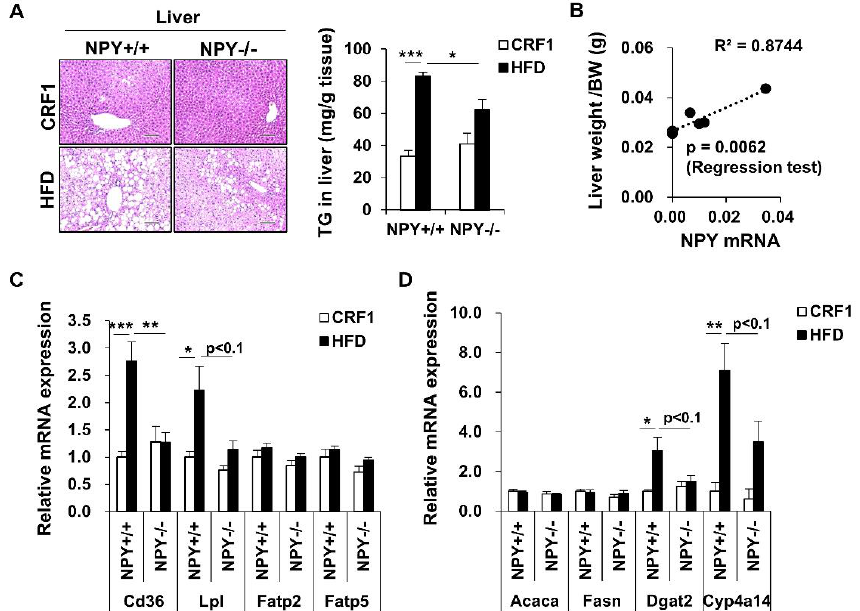
Figure 5. Deletion of NPY improves HFD-induced liver steatosis. ( A ) Representative H&E (hema- toxylin and eosin) staining of liver. Scale bar, 100 µ m (left panel), liver triglyceride level in WT and KO mice (right panel), ( n = 4 per group), ( B ) Correlation of NPY mRNA levels in peritoneal macro- phage with liver mass/BW ratio from mice fed-HFD, ( C , D ) mRNA expression level genes involved in fatty acid uptake and lipogenesis in liver from WT and KO mice. All data are presented as the mean ± SEM ( n = 5 –6 per group). Student’s two -tailed t test, * p < 0.05, ** p < 0.01, and *** p < 0.001.